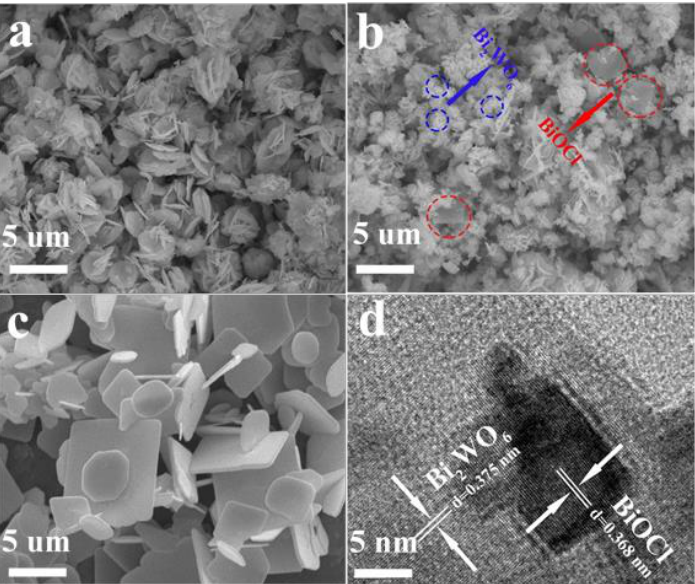
Figure 2. ( a ) SEM and TEM images of as-prepared samples: SEM image of Bi 2 WO 6 , ( b ) BWOC2(Bi 2 WO 6 /BiOCl composite samples), and ( c ) BiOCl; ( d ) HRTEM image of BWOC2. Bi2WO6 is marked in blue color, BiOCl is marked in red color.